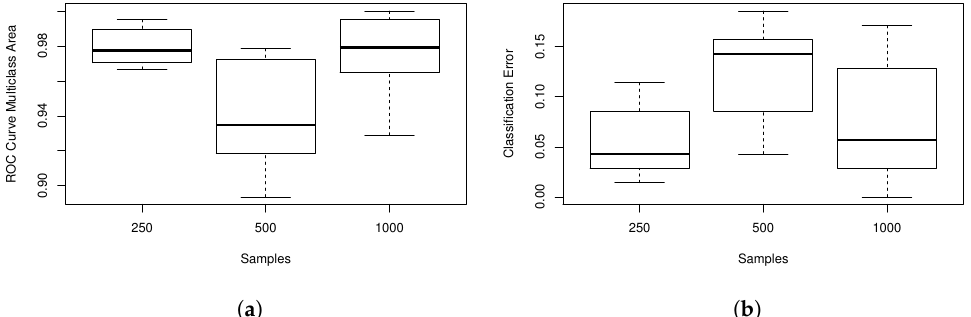
Figure 5. ( a ) Area under the curve estimation of ROC curve multi-class for different window sizes using all channels. ( b ) Error classification estimation for different window sizes using all